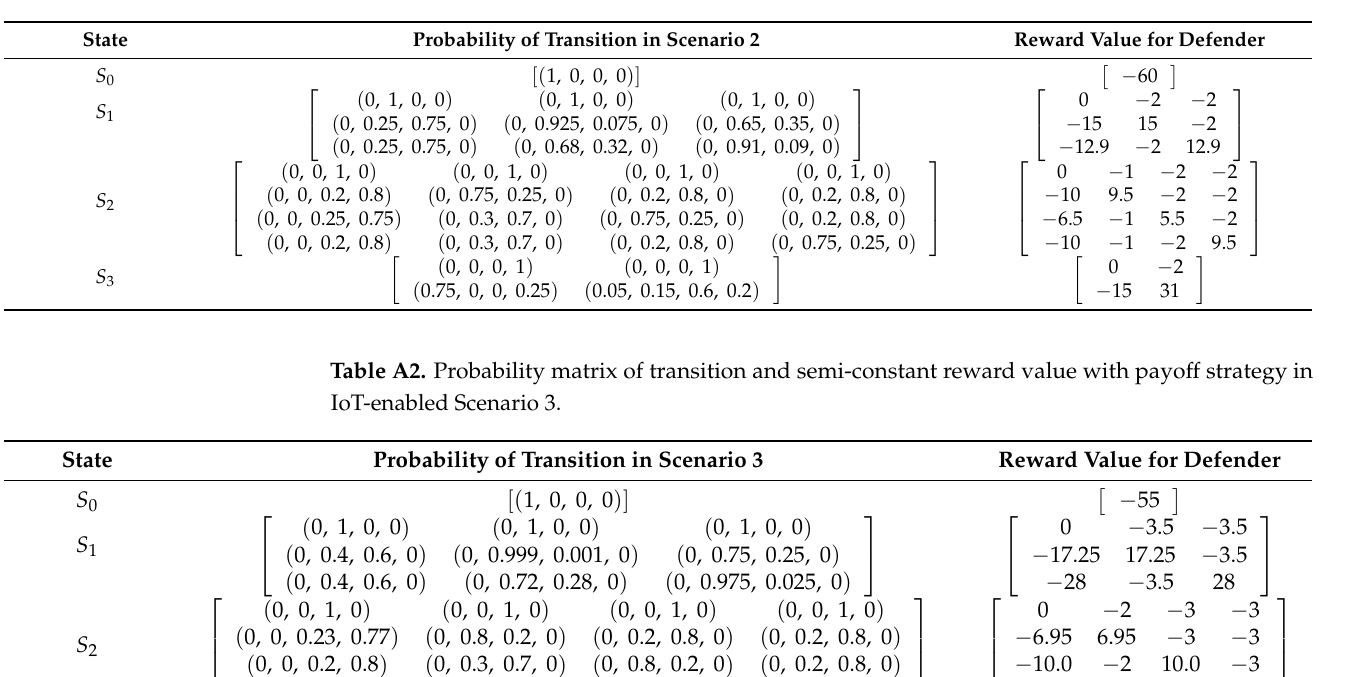
Table A1. Probability matrix of transition and semi-constant reward value with payoff strategy in IoT-enabled Scenario 2.